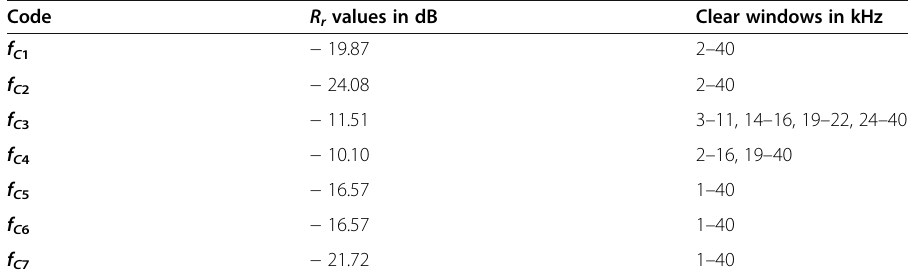
Table 8 R r values and clear windows of the codes obtained